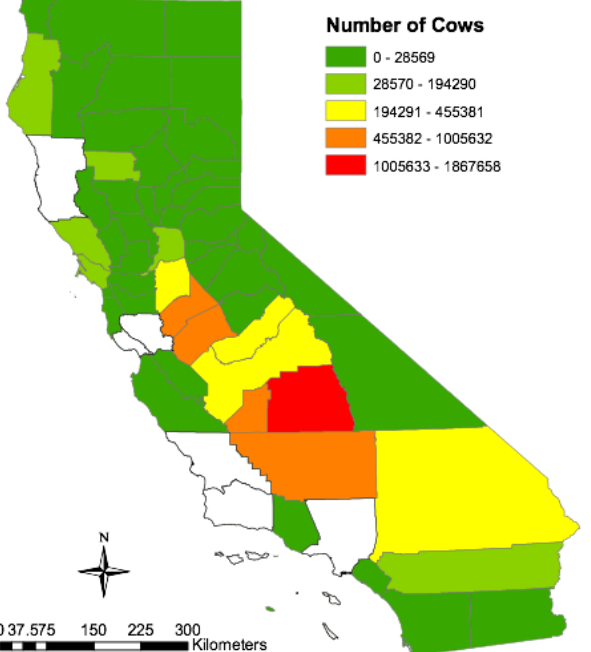
Figure 4. The number and distribution of live cows in California farms in counties (California Department of Food and Agriculture, 2008).